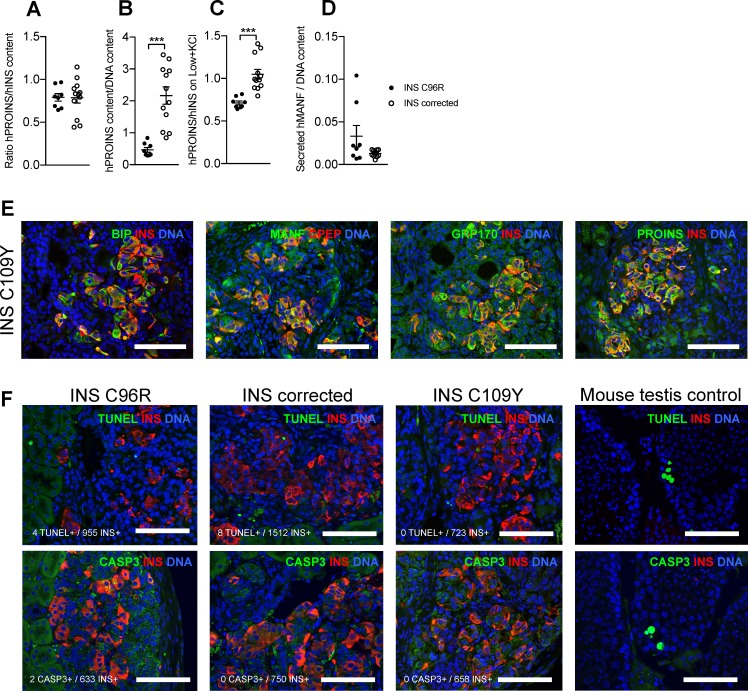
Characterization of in vitro Stage 7 cells and 3 months old grafts.Related to Figures 3, 4 and 5. (A) Ratio of human proinsulin to insulin content of Stage 7 islet-like aggregates. (B) Human proinsulin content of Stage 7 islet-like aggregates. (C) Ratio of human proinsulin to human insulin secretion in response to maximal stimulation with Low glucose + KCl of Stage 7 islet-like aggregates. (D) Overnight secretion of human MANF by Stage 7 islet-like aggregates. ***p < 0.001, Student’s t test for (B), Student’s t test with Welch’s correction for (C). Data represent mean ± SEM, n = 8–12 independent stimulations per cell genotype. (E) Immunohistochemistry for apoptosis markers TUNEL and CASP3 in INS+ cells. (F) Immunohistochemistry for ER-stress markers BIP, MANF, GRP170 and proinsulin (PROINS) in INS C109Y 3 month old grafts. Scale bars = 100 µm.